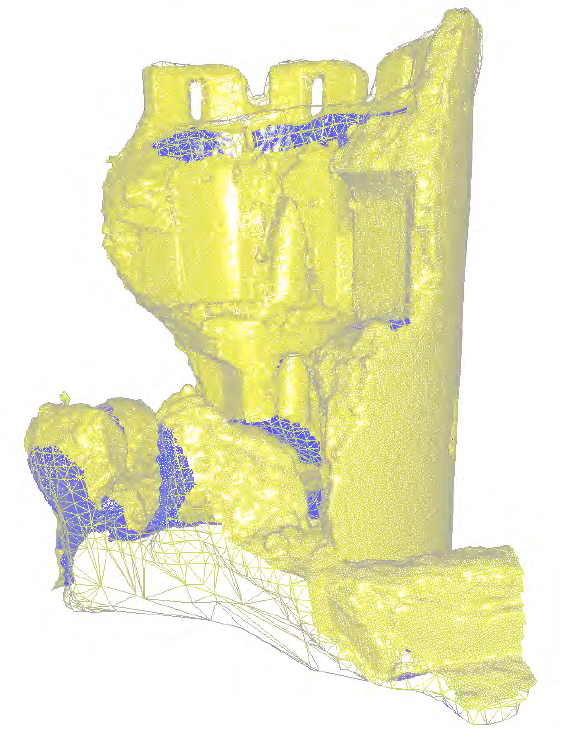
Figure 6. Superimposition of TIN mesh and Poisson reconstruction surface.